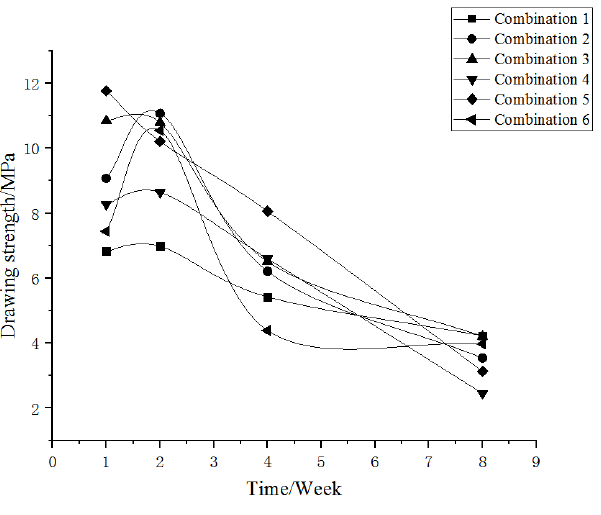
Figure 10. 60 ◦ C water bath pulling strength. Figure 10. 60 °C water bath pulling strength.